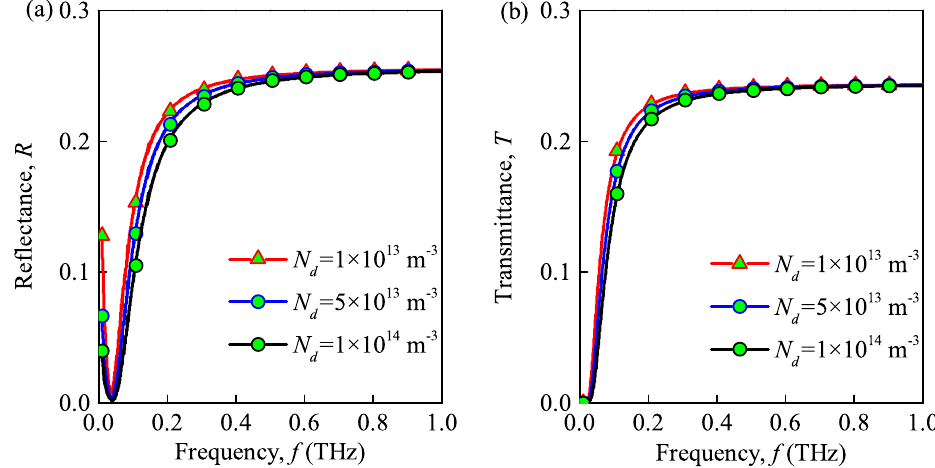
Figure 6. Reflectance ( a ) and transmittance versus ( b ) wave frequency under different dust particle